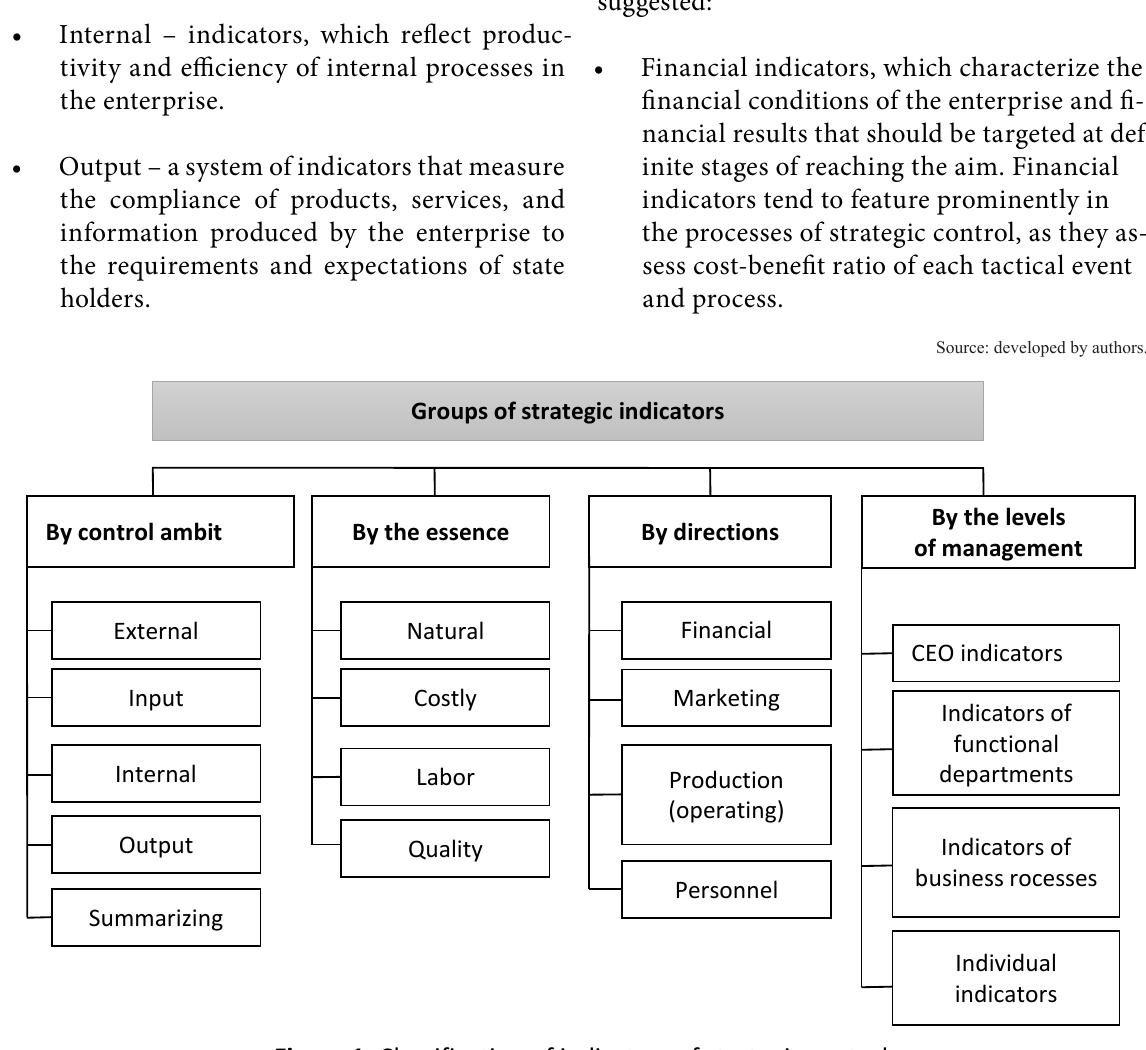
Figure 1. Classification of indicators of strategic control